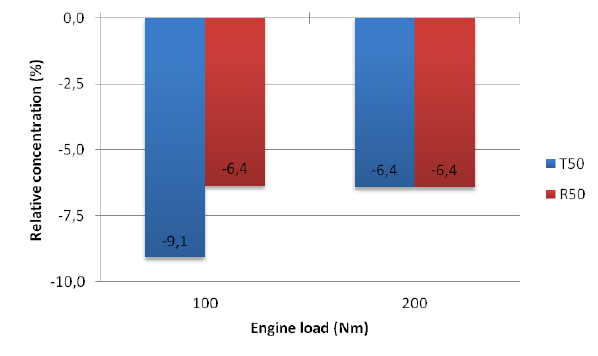
Fig. 7. Hydrocarbons concentration in relation to DF for T50 and R50